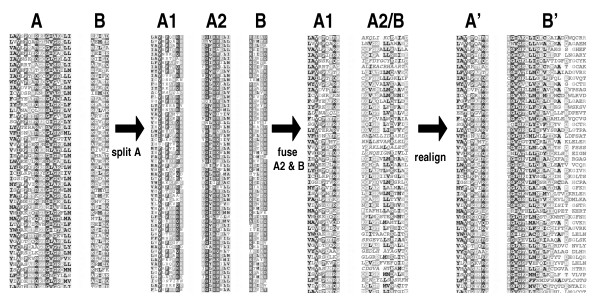
An example of a series of compound operations applied to a motif based alignment. This series splits and fuses blocks in order to escape from kinetic traps in alignment space. See text for details.